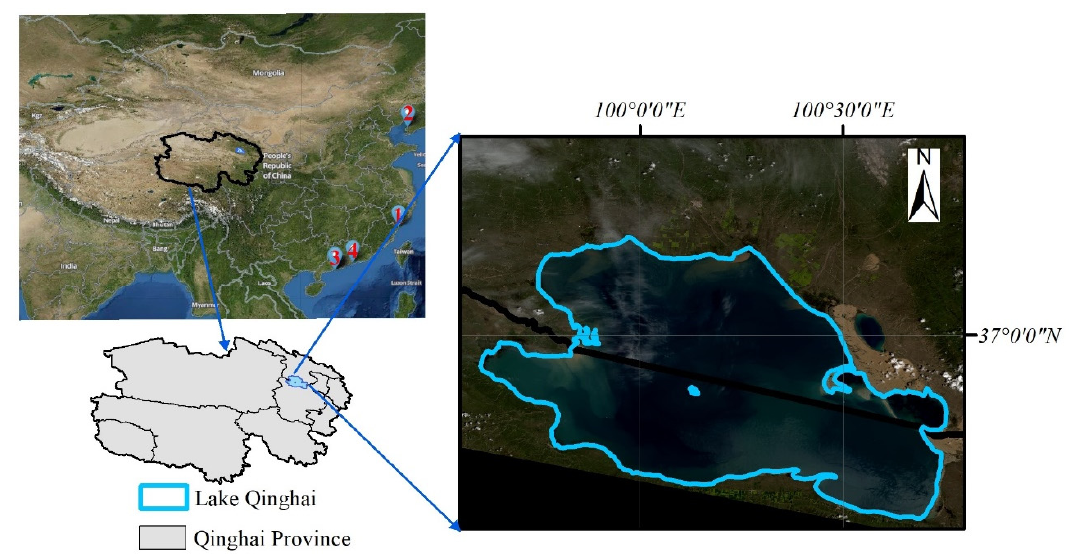
Figure 1. Relative location of Lake Qinghai, China. Red numbers in figure are field experiment sites.